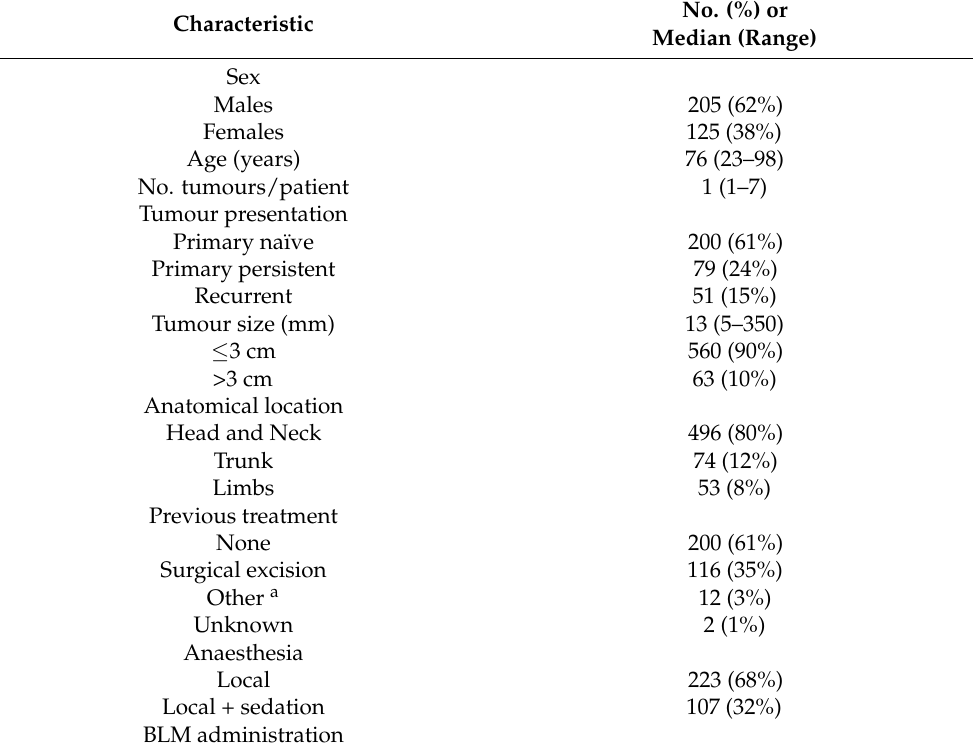
Table 1. Patient and treatment characteristics (330 patients with 623